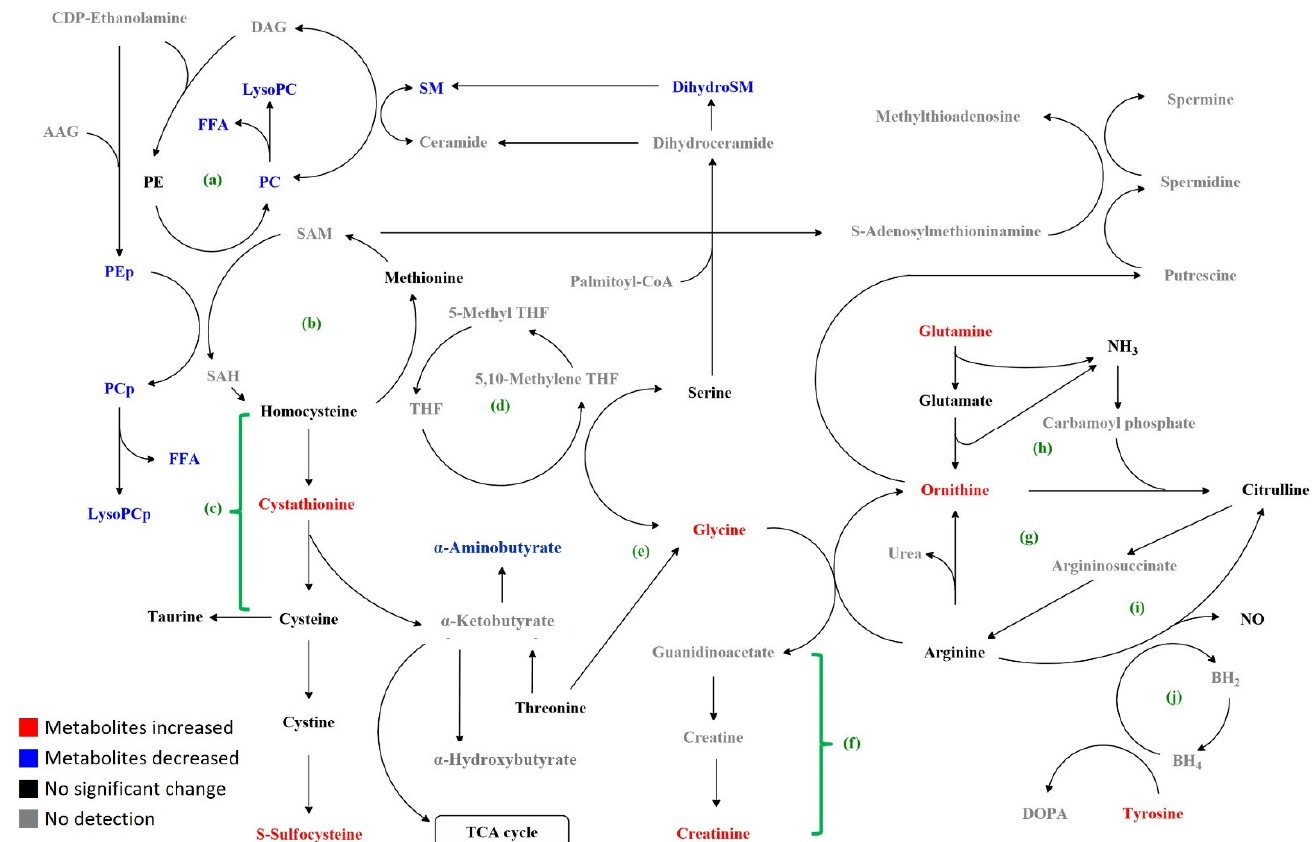
Figure 5. Map of metabolic changes in PD compared to the controls . ( a ) Sphingolipid and related glycerophospholipid biosynthetic pathways; ( b ) methionine cycle; ( c ) transsulfuration pathway; ( d ) folate cycle; ( e ) glycine, serine, and threonine pathway; ( f ) creatine synthesis pathway; ( g ) urea cycle; ( h ) ornithine–proline–glutamate pathway; ( i ) nitric oxide (NO) synthesis pathway; ( j ) biopterin cycle. AAG: alkyl acylglycerol; BH 4 : tetrahydrobiopterin; BH 2 : dihydrobiopterin; DAG: diacylglycerol; dihydroSM: dihydrosphingomyelin; DOPA: dopamine; FAA: free fatty acid; LysoPC: lysophosphatidylcholine; PC: phosphatidylcholine; PCp: phosphatidylcholine-plasmalogen; PE: phosphatidylethanolamine; PEp: phosphatidylethanolamine-plasmalogen; SM: sphingomyelin; SAM: S-S-adenosyl methionine; SAH: S-adenosyl homocysteine; TCA: tricarboxylic acid.